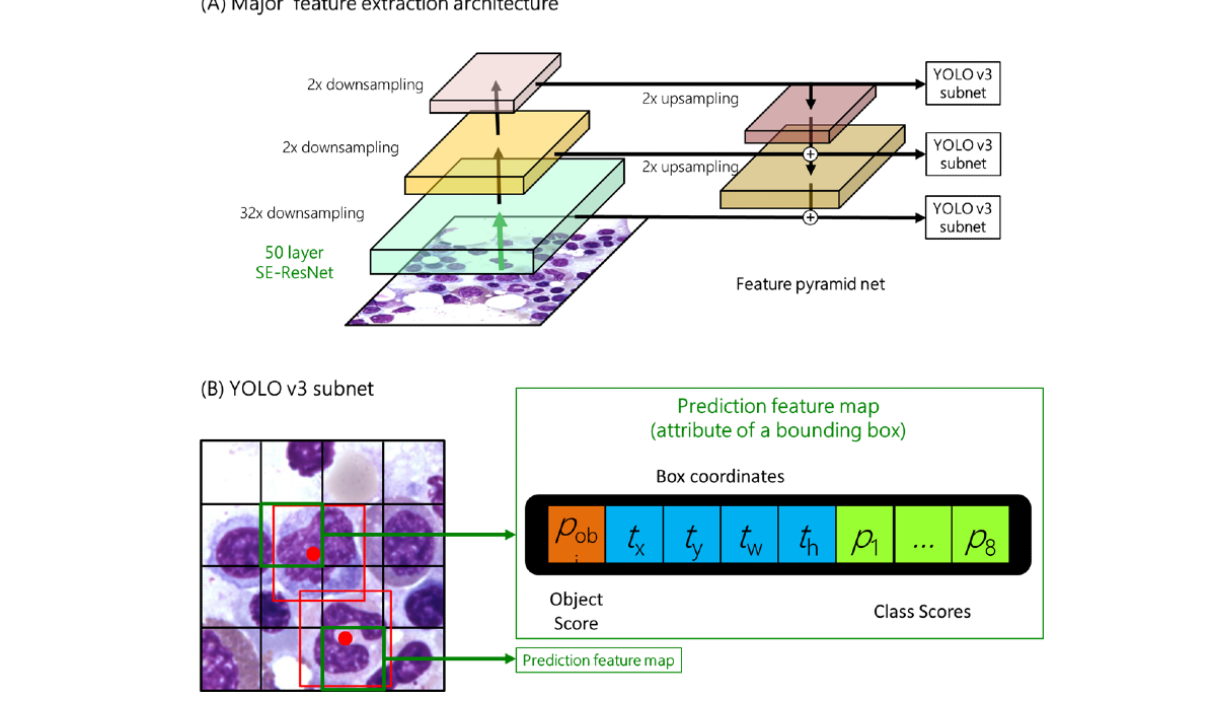
(Table 2: Panel). The panels were, then, sent for FACS